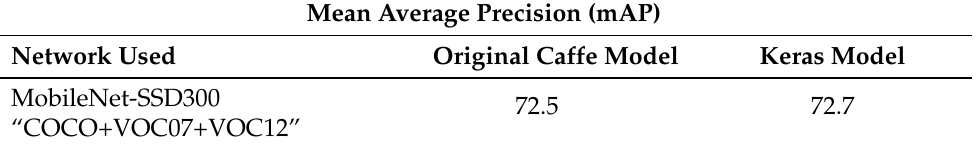
Table 1. Mean average precision